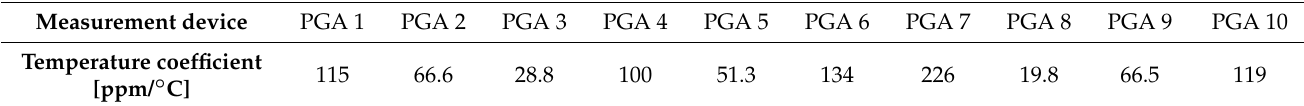
Table 6. Experimental temperature coefficients of